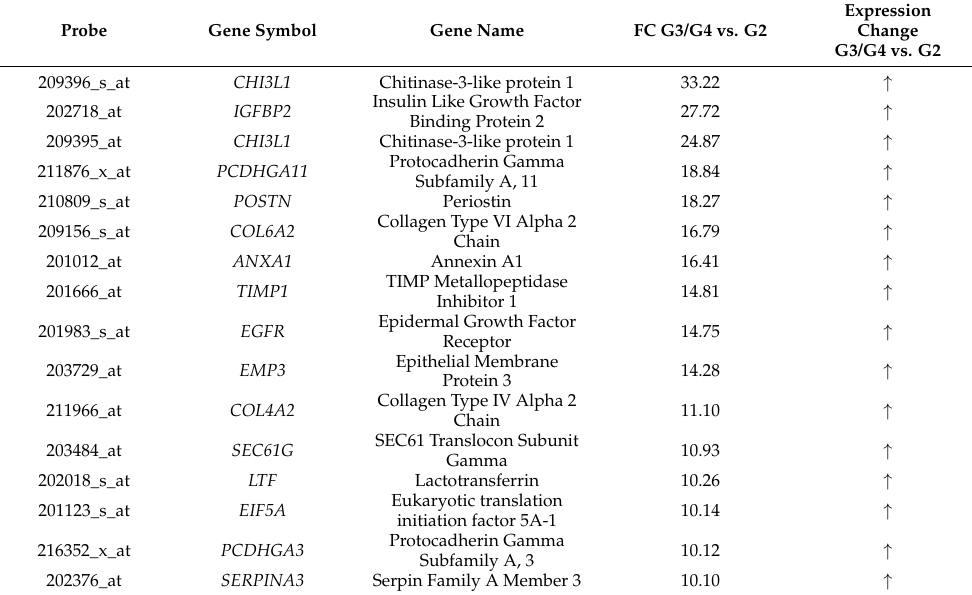
Table 4. Characteristics of genes showing altered expression in gliomas of different